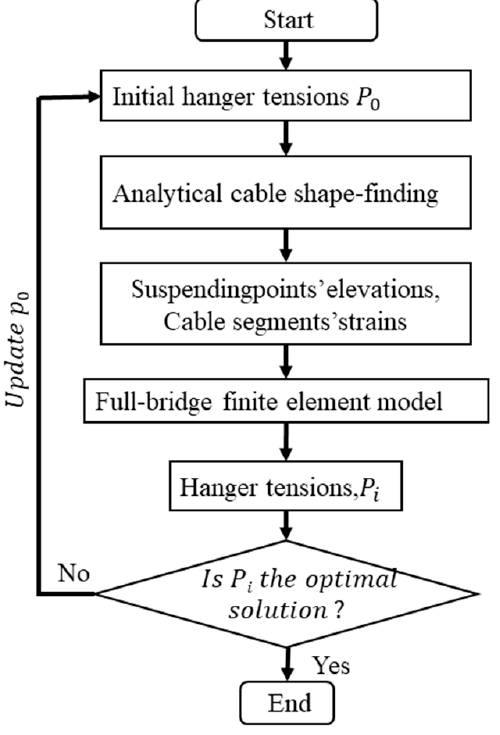
Figure 7. Flow chart of the calculation process.